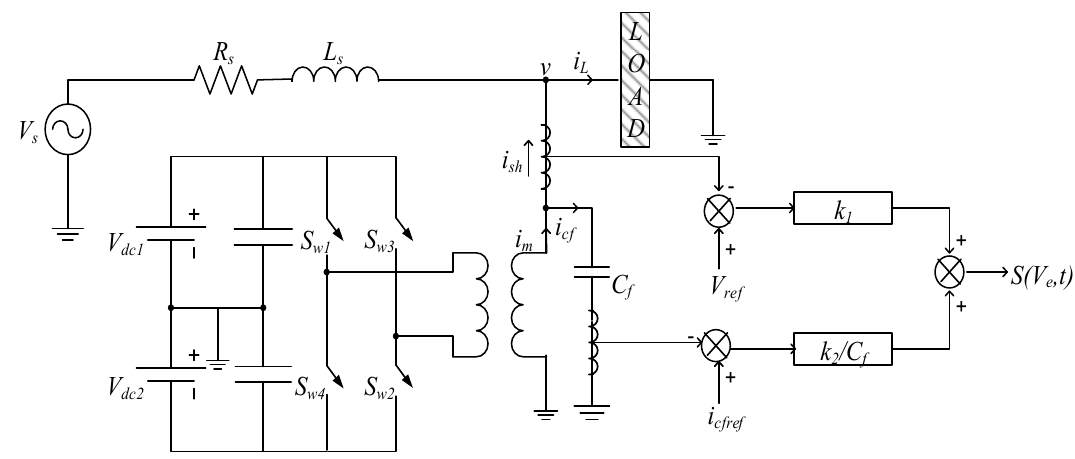
Figure 3. DSTATCOM in sliding mode control (SMC).